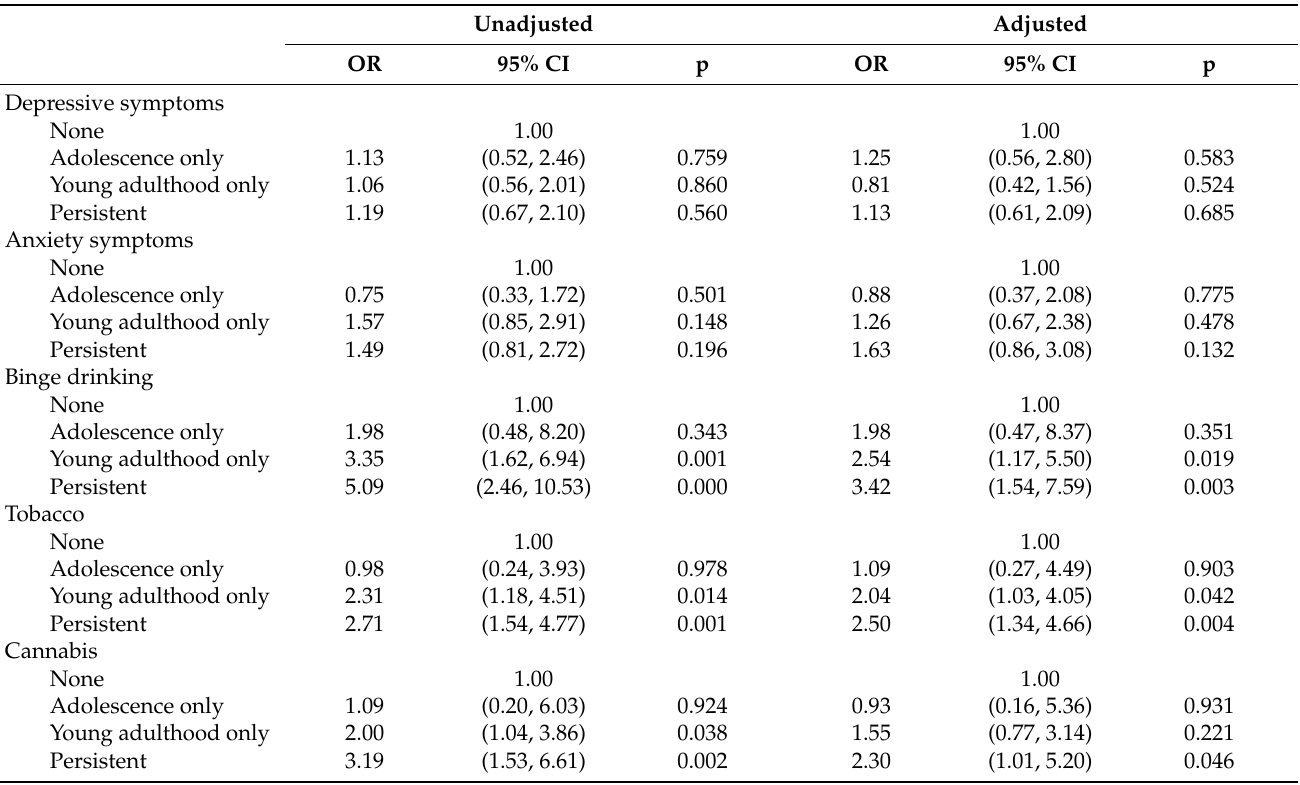
Table 2. Models regressing any-risk gambling on to each mental health and substance use history.